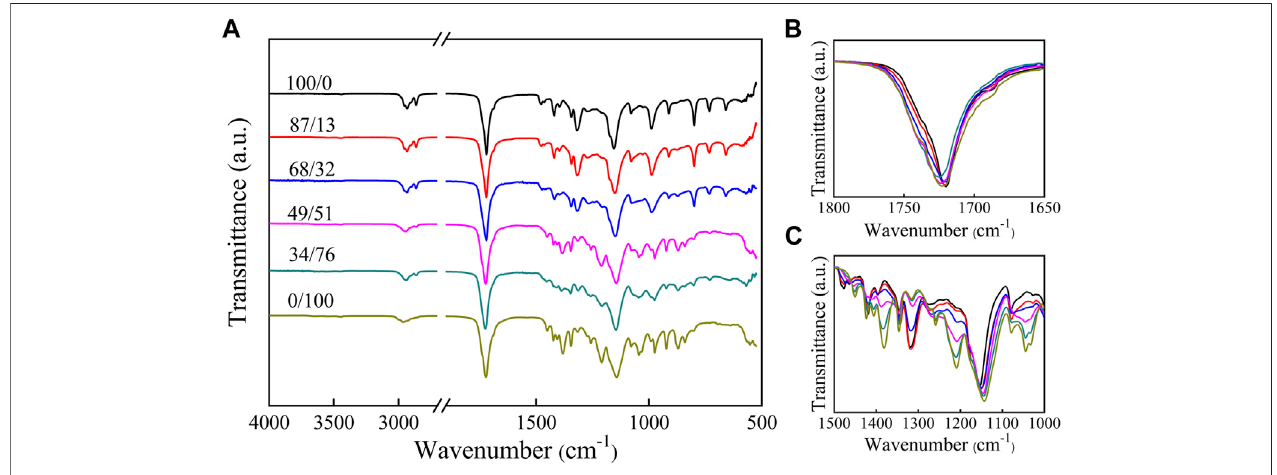
FIGURE 2 | FT-IR spectra of PHS, PES, and P(HS-co-ES) copolyesters at various frequencies: (A) 4,000 – 500 cm − 1 ; (B) 1800 – 1,650 cm − 1 ; and (C) 1,500 – 1,000 cm − 1